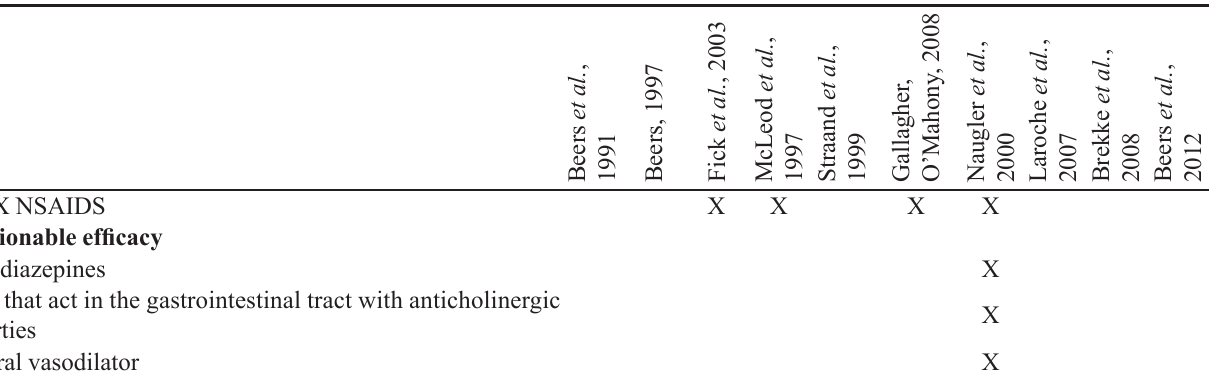
NSAIDs: nonsteroidal anti-inflammatory drugs; COPD: chronic obstructive pulmonary disease; ACEI: angiotensin-converting- enzyme inhibitor; MAOI: monoamino oxidase inhibitor; SSRI: selective serotonin reuptake inhibitor; CNS: central nervous system.